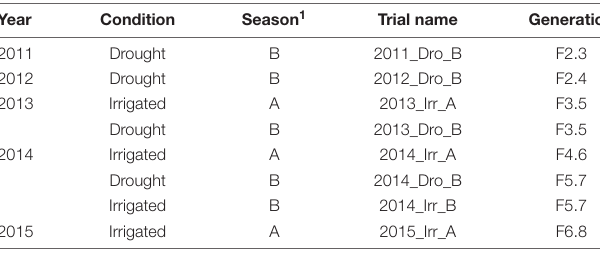
TABLE 1 | Description of trials used in the